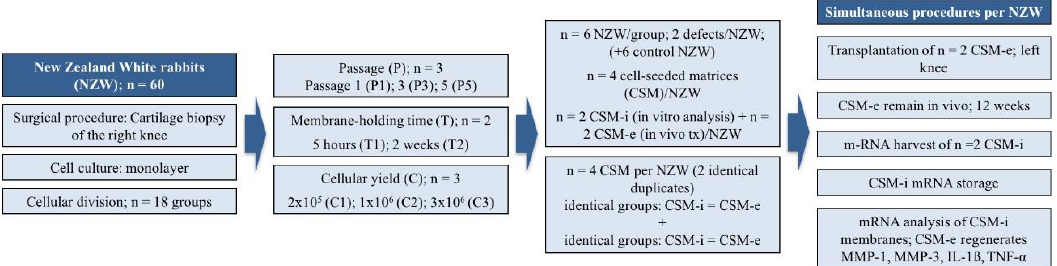
Figure 7. Study design overview. A total of 60 New Zealand White Rabbits (including 6 rabbits as control group) were included. From 54 included rabbits, harvested chondrocytes were